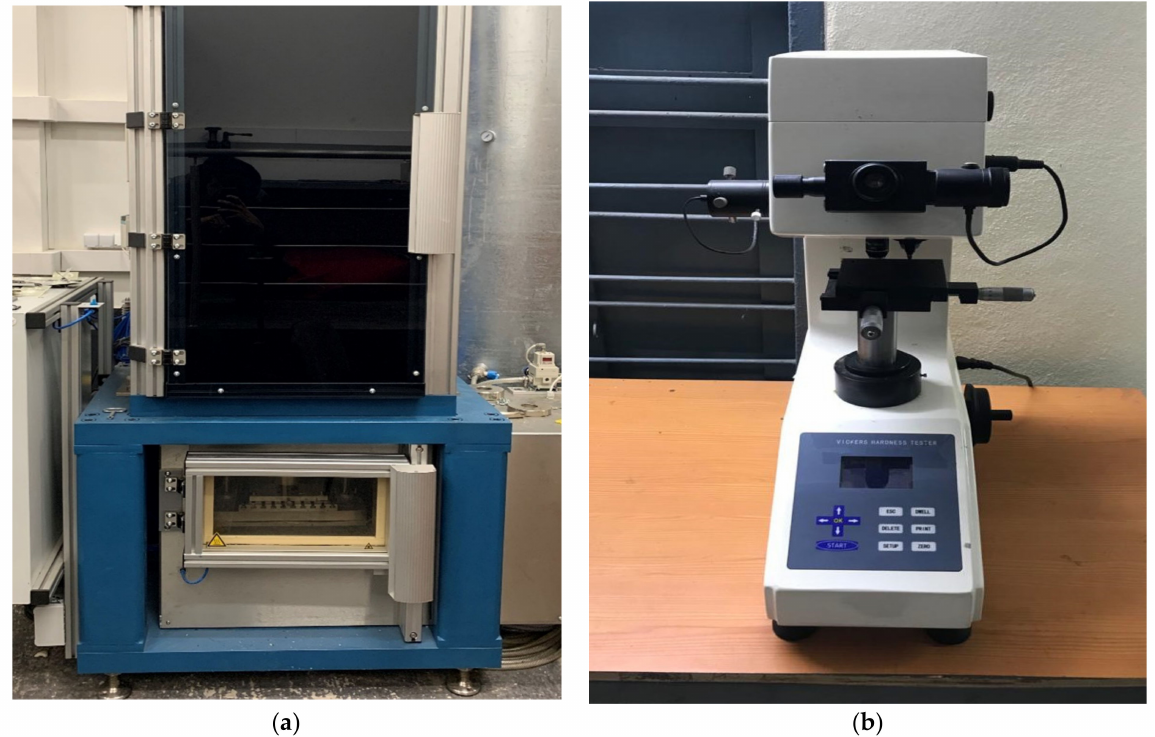
Figure 4. Coesfeld Magnus Impact testing system ( a ) Micro Vickers hardness tester ( b